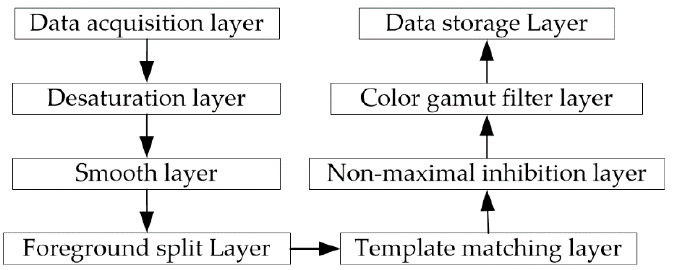
Figure 4. Hierarchical model of visual environment monitoring.